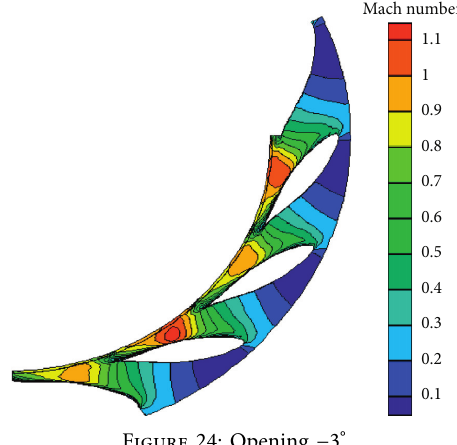
Figure 24: Opening − 3 °